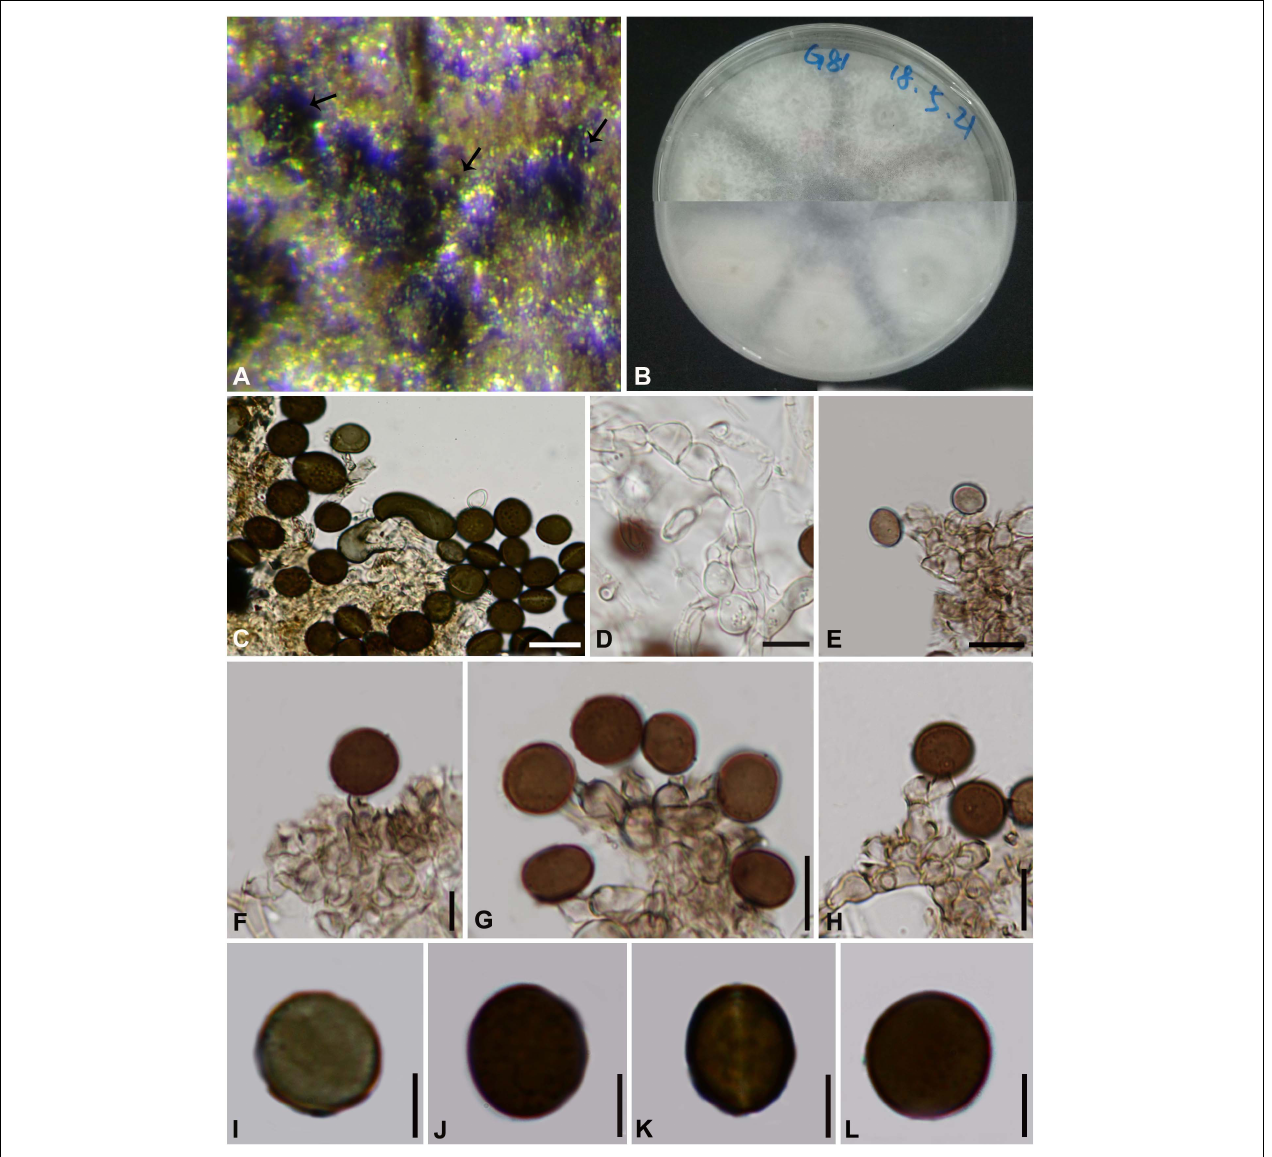
FIGURE 5 | Arthrinium cyclobalanopsidis ( HKAS 111963, holotype) (A) Conidia masses on host. (B) Culture. (C) Sterile cell mixed among conidia. (D) Hyphae of chain structure. (E–H) Conidiogenous cells and conidia. (I–L) Conidia. Scale bars: (C–H) = 10 µ m. (I–L) = 5 µ